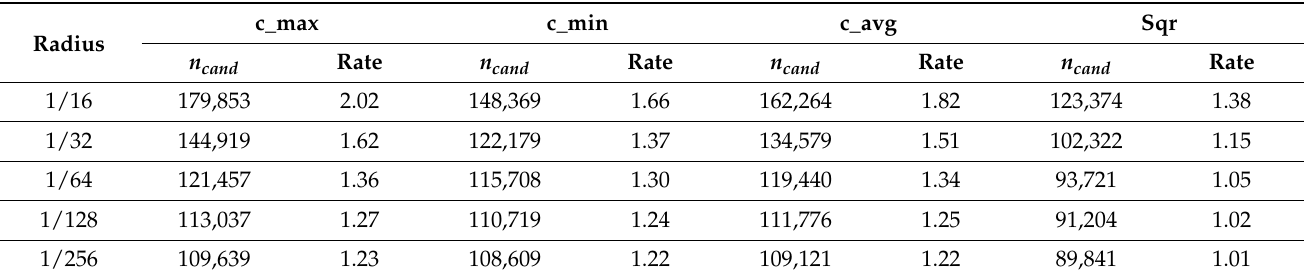
The rate is n cand divided by n inner . Table 6 provides the number of outer points n outer . When the radius was 1/16, n outer of c_max was 90,644, i.e., n cand − n inner . When the radius went from 1/16 to 1/256, n outer of c_max went from 90,644 to 20,430, n outer of c_min went from 59,160 to 19,400, n outer of c_avg went from about 73,055 to 19,912, and n outer of sqr went from 34,165 to 632. When the radius was 1/16, n outer of c_max was 90,644, and n outer of sqr was 34,165. The number of outer points was reduced to 56,479, and the reduction rate was about 62.3% (=56,479/90,644). Figure 12 provides the reduction rates of c_max#sqr, c_min#sqr, and c_avg#sqr. When the radius was 1/16, the reduction rates of c_max#sqr, c_min#sqr, and c_avg#sqr were about 62.3%, 25.6%, and 53.2%. When the radius was reduced to 1/256, the reduction rates of c_max#sqr, c_min#sqr, and c_avg#sqr were about 96.9%, 91.9%, and 96.8%. Accordingly, sqr resulted in a reduction rate of the outer points between 25.6% and 96.9% with respect to c_max, c_min, and